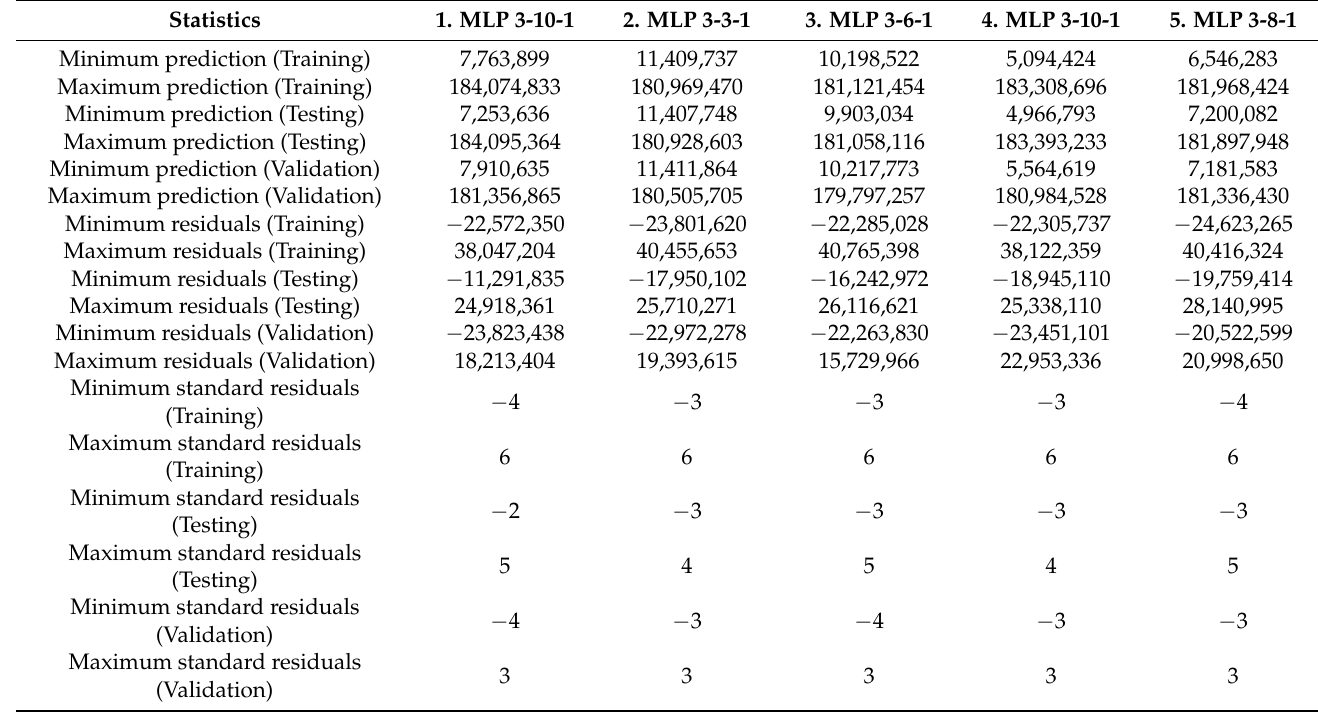
Table A2. Basic statistics of equalized time series—1-month delay.